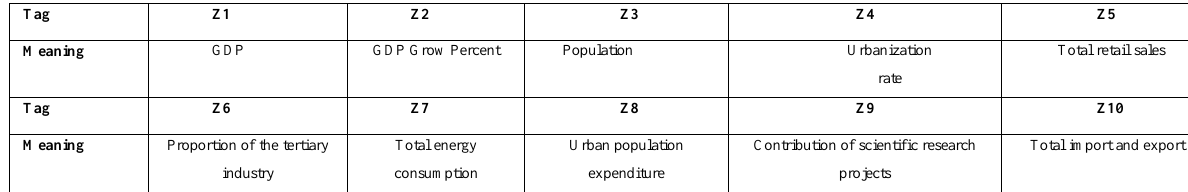
Table 3. Relative factors of ED and their tag